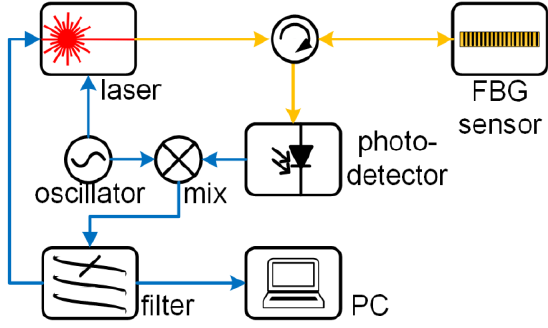
Figure 7. The FBG demodulation systems using modulated.